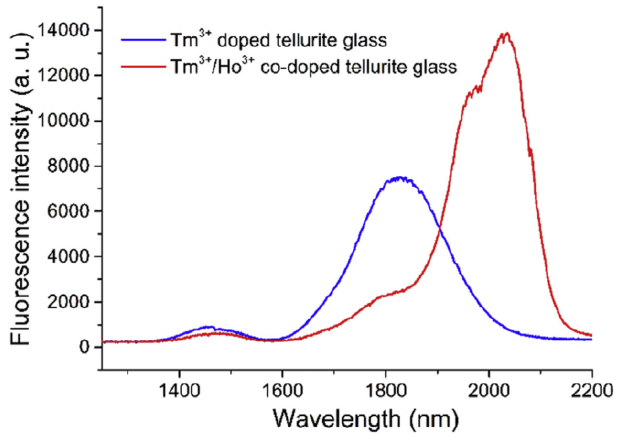
Figure 12. Fluorescence spectrum of the Tm 3+ doped and Tm-Ho co-doped tellurite glasses. Reprinted/Adapted with permission from [81].